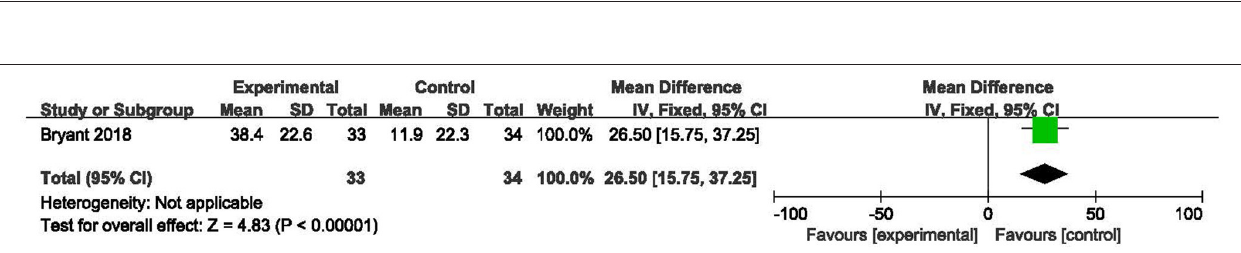
FIGURE 2 | Forest plot of network meta-analysis of the end-of-treatment effect on post-traumatic stress disorder symptom severity between cognitive behavioral therapy-brief and no treatment.